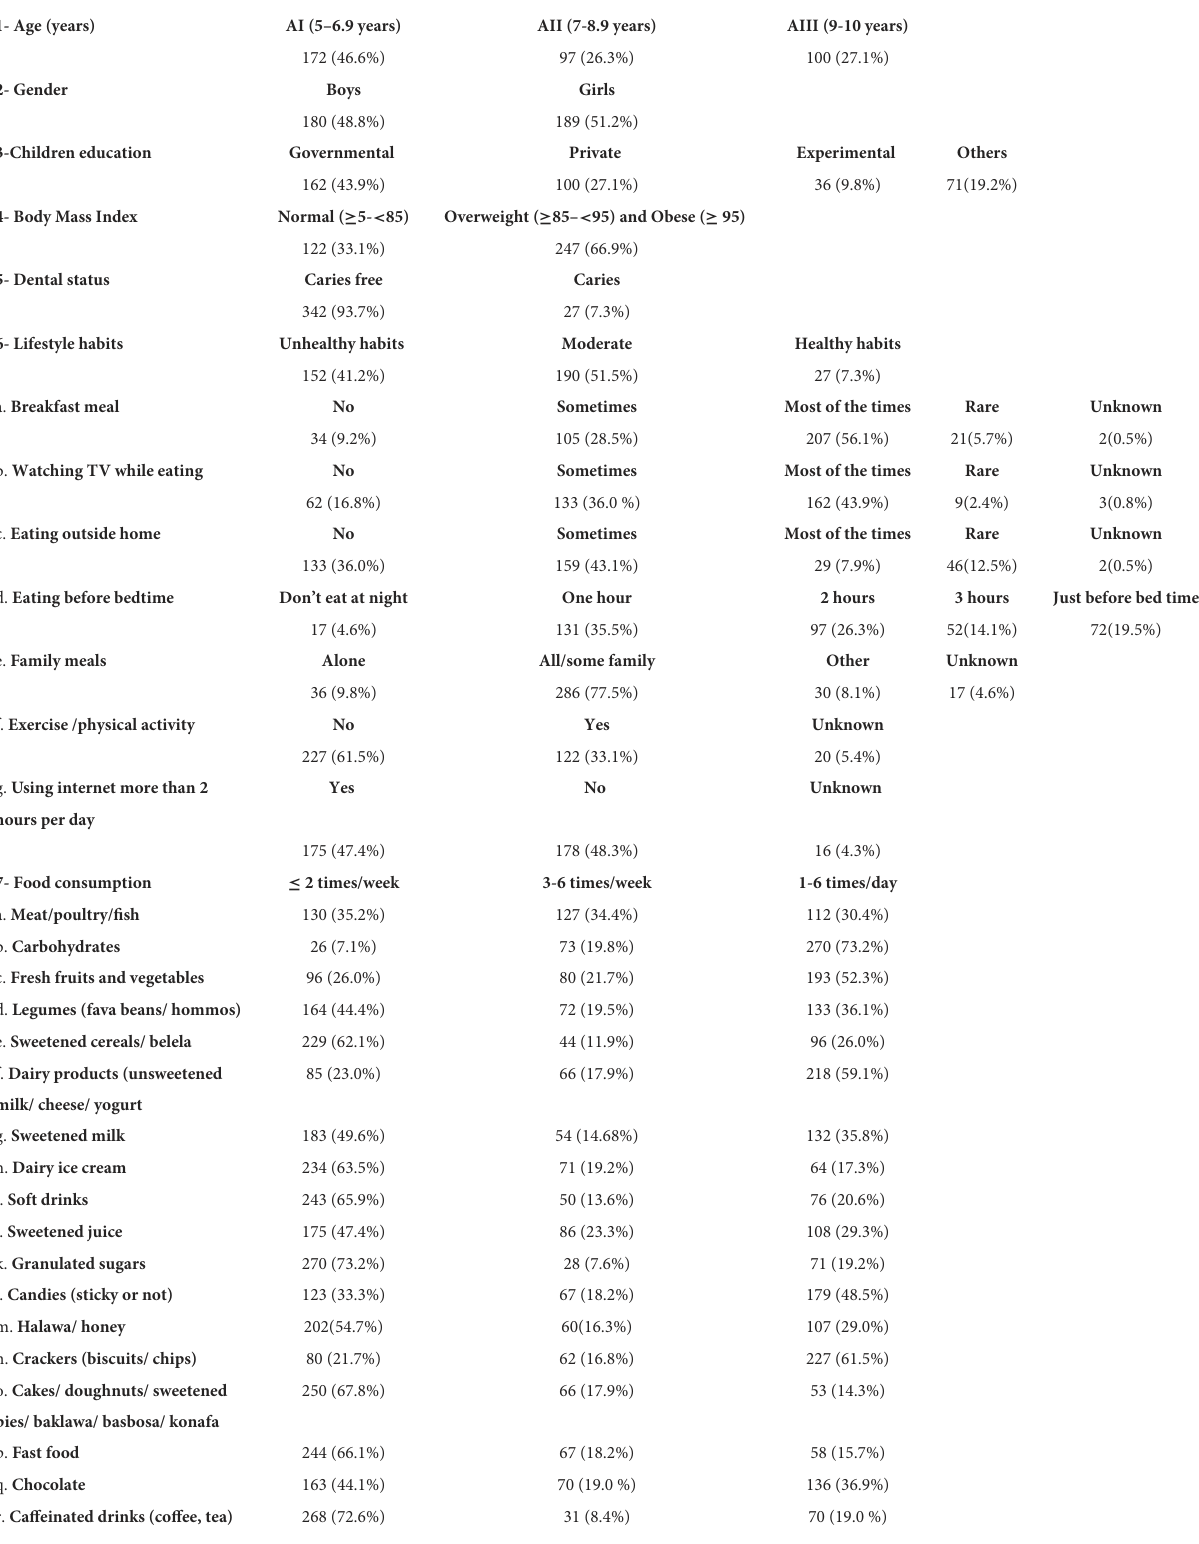
TABLE 2 Demographics, lifestyle habits and dietary